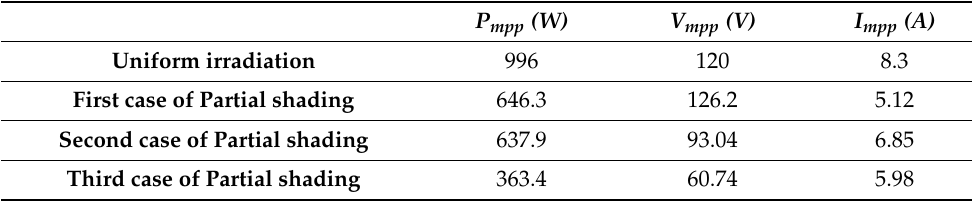
Table 4. PV characteristics study for a different type of